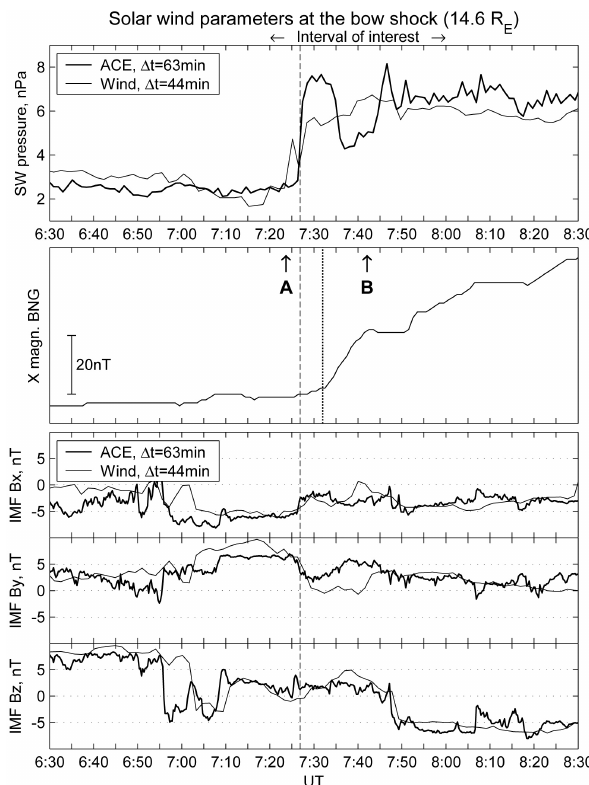
Fig. 2. Solar wind and IMF parameters time shifted to account for the propagation delay from the satellites to the bow shock. Vertical dashed and dotted lines indicate the moments of the pulse arrival at the bow shock and the detection of its response at the low-latitude magnetic observatory Bangui, respectively. Letters A and B denote the moments for which global auroral images will be considered (Fig.